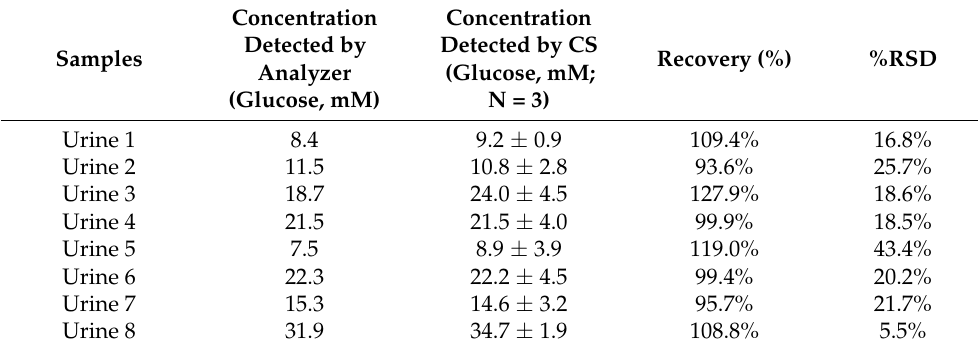
Table 2. Detection of glucose concentrations in real urine samples using the CS and commercial glucose analyzer.